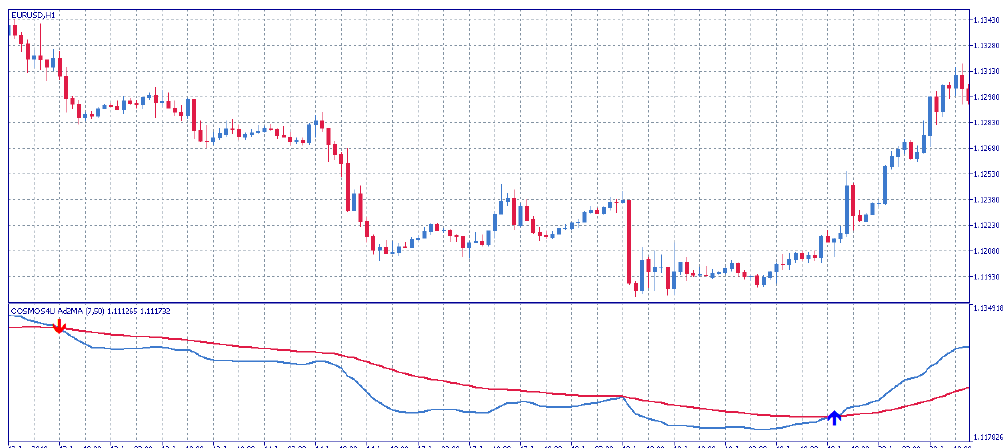
Figure A2. EUR/USD chart with signals from the Ad2MA strategy